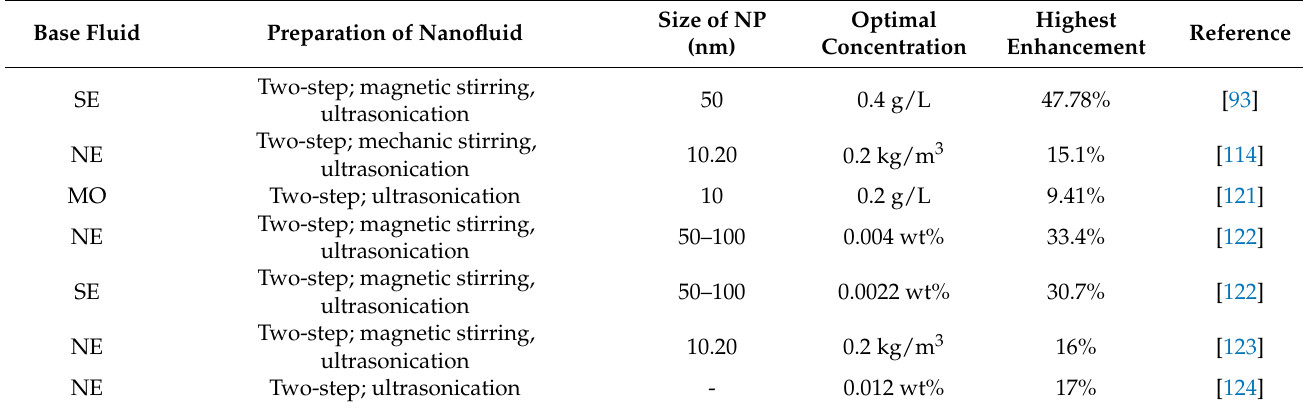
Table 7. Fe 3 O 4 and Fe 2 O 3 AC-BDV overview table. The size of NP refers to the nanoparticle core size, while the optimal concentration indicates the concentration value for which the maximal enhancement of AC-BDV was found. Base